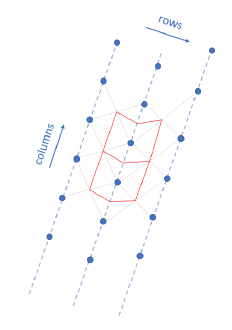
Figure 8. Using the orthorectified center points of a pixel and of its neighbours, a hexagon is defined. The points defining this one are subsequently orthocorrected to raster resampling. In practice, this means that each pixel is transformed into a hexagon, each vertex being defined with re- gard to the centre points of the neighbouring pixels (see figure 8). The vertices of the hexagon are then orthocorrected and the intersection with the 2D ‘deviation’ geometry is